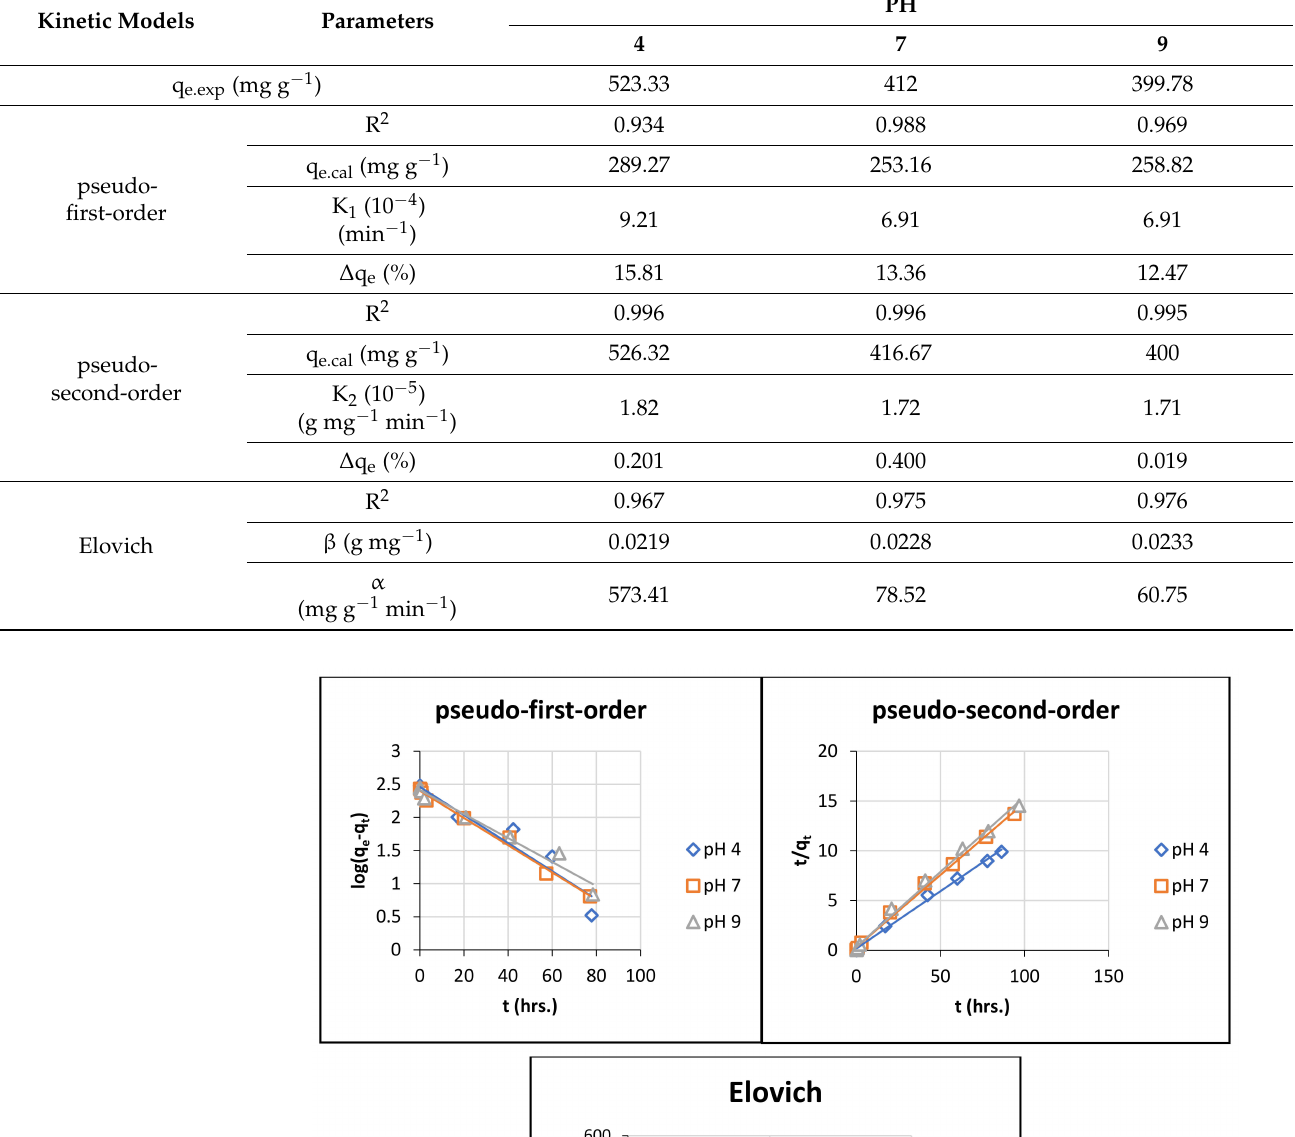
Table 1. Kinetic model constants and correlation coefficients for the adsorption of CR dye onto UCs at different pH.